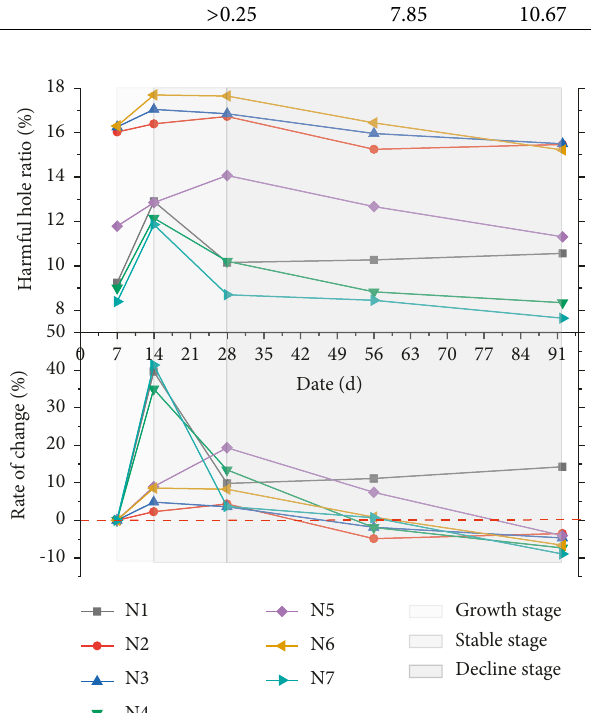
Figure 10: Harmful hole ratio of N1 ∼